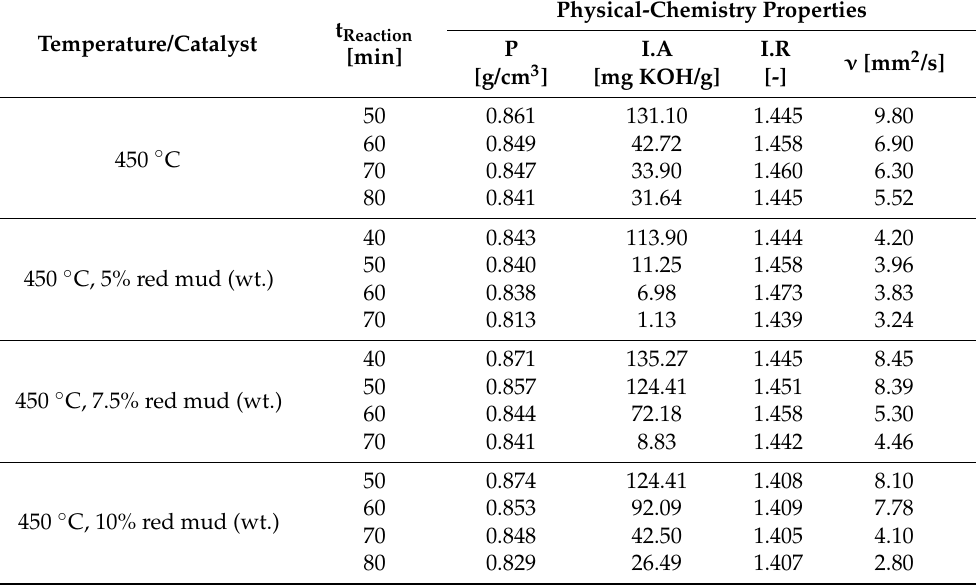
Table 8. Effect of reaction time on the physicochemical properties of bio-oil obtained through the upgrading